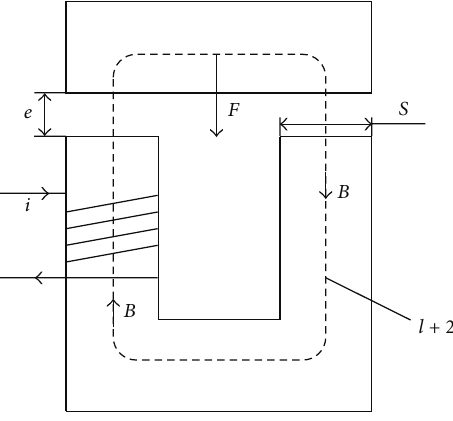
Figure 3: Construction of U-electromagnet.